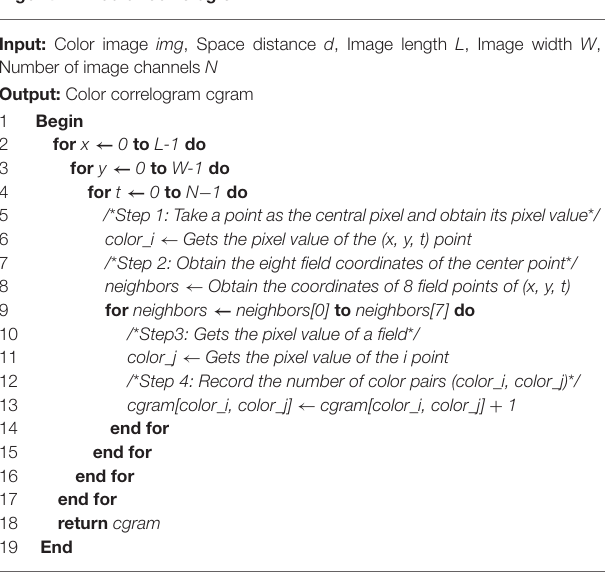
TABLE 2 | Pseudo code of color correlation diagram. Algorithm 1 color